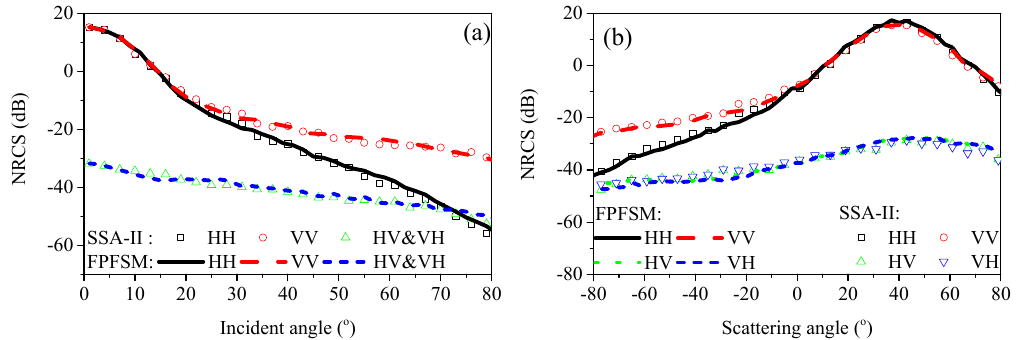
Figure 5. Comparison of the NRCS results calculated by FPFSM and SSA-II at ultra high frequency (UHF) band. ( a ) Monostatic configuration; ( b ) Forward–backward configuration.